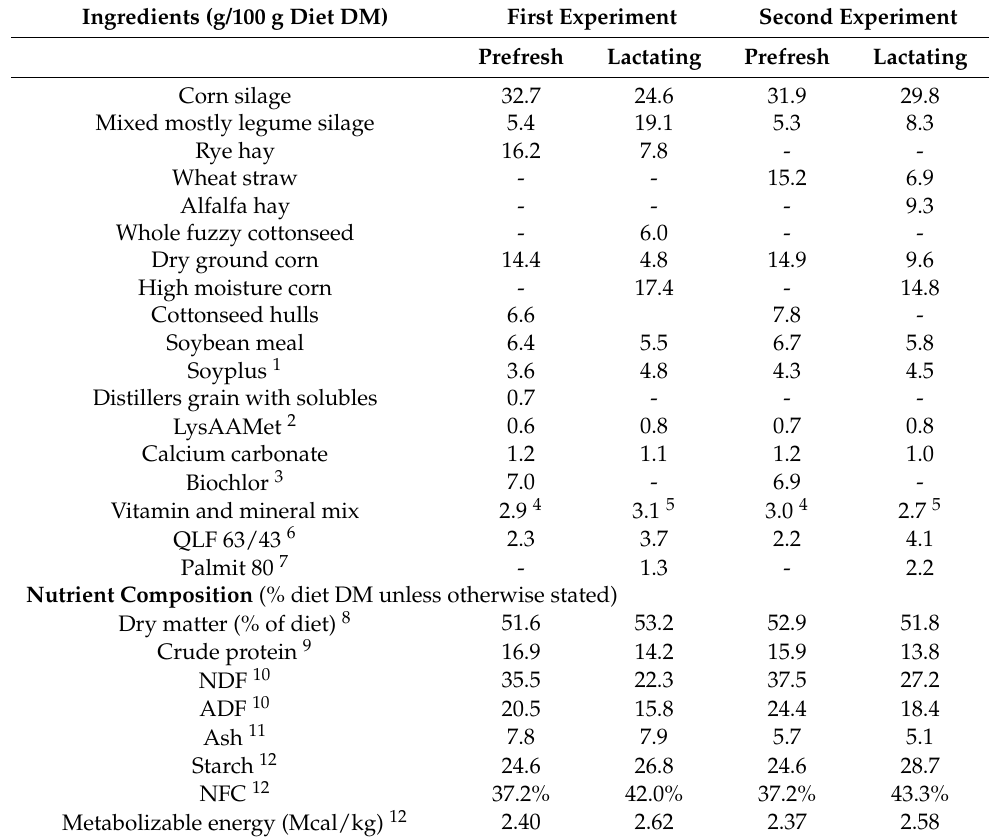
Table 1. Nutrient composition for the two rations fed during the two experiments. The prefresh diet was fed from 35 d before expected calving (BEC) to parturition; the lactating diet was fed from 0 to 60